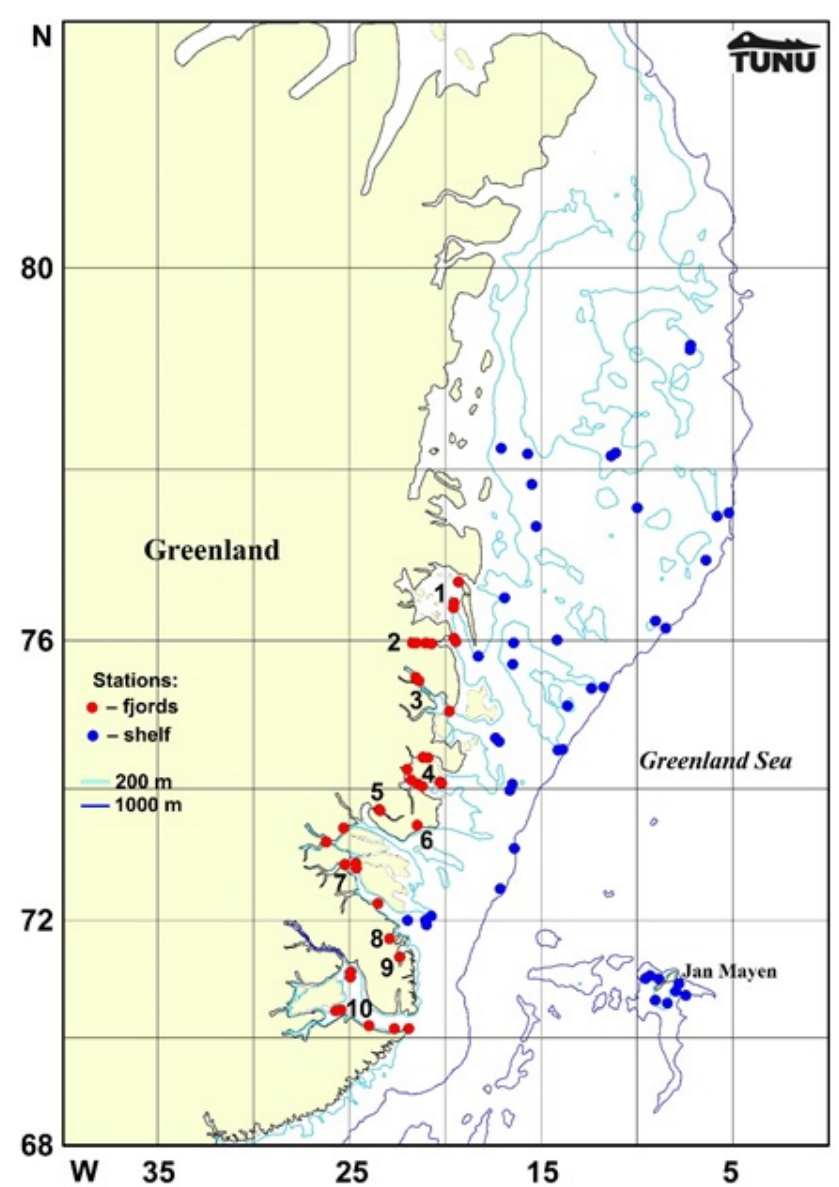
Figure 1. Fjord and shelf stations (N = 83) sampled in Northeast Greenland and at Jan Mayen Island during years 2002–2017. The investigated fjords comprise: 1—Dove Bugt, 2—Bessel Fjord, 3—Brede Fjord, 4—Clavering Ø fjord system, 5—Moskusokse Fjord, 6—Myggbukta, 7—Kong Oskar Fjord, 8—Fleming Fjord, 9—Carlsberg Fjord, 10—Scoresby Sund fjord system.